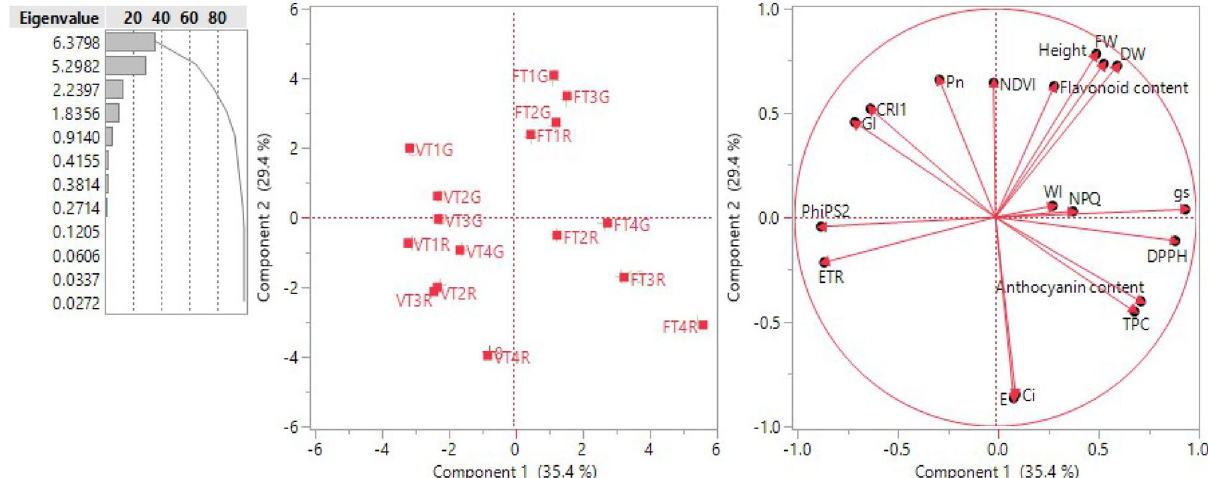
Figure 7. Principal components analysis using the correlation matrix built using data for differential biomass accumulation, physiological response parameters and antioxidant capacity in the two cultivars and two developmental stages grown under four different light spectrum ratios (T1; 3R:1B, T2; 1R:1B, T3; 2R:1G:2B and T4; 1R:3B). R, G and B represent the red, green and blue llight spectra, respectively, and number before the letters stand for the ratio of each lighrt